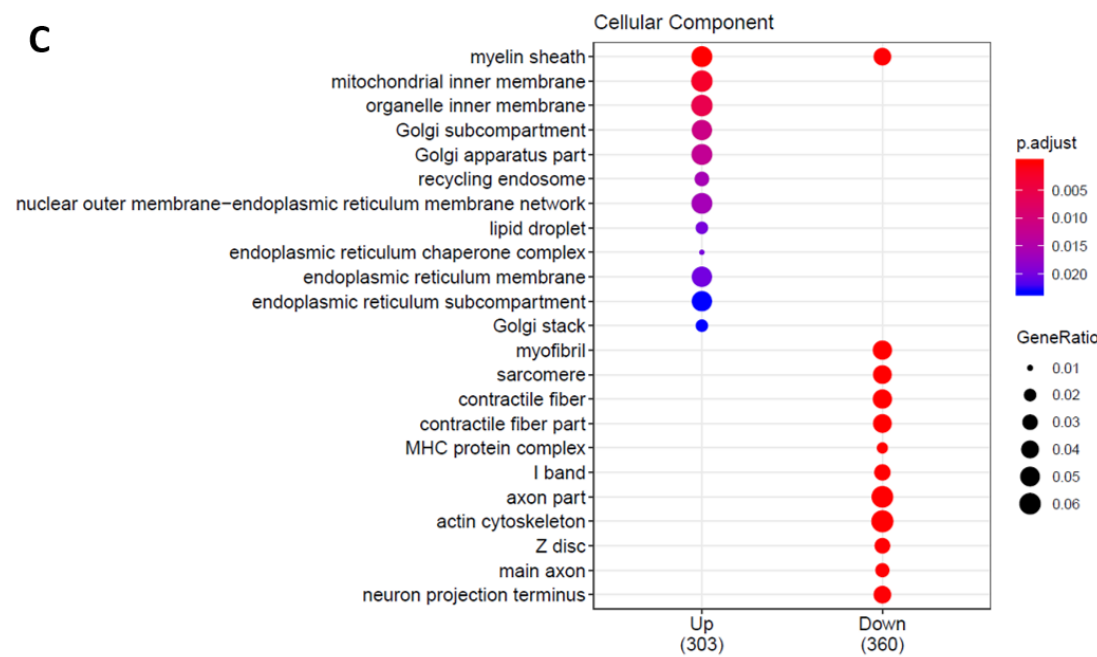
Figure 2. Cell type specific effect of oxaliplatin and enrichment analysis of the overlapping DEGs. ( A ) Cell type enrichment analysis (CTEN) of DEG in lumbar dorsal root ganglia L3 to L5 following repeated oxaliplatin administration. CTEN was performed using the CTen tool. The score is generated using one-sided, Fisher’s exact test for enrichment and it is shown as the -log10 of the Benjamini-Hochberg (BH) adjusted P values. Scores > 20 optimally minimize the false positive rate. ( B , C ) illustrate the GO enrichment analysis results: ( B ) biological process, ( C ) cellular